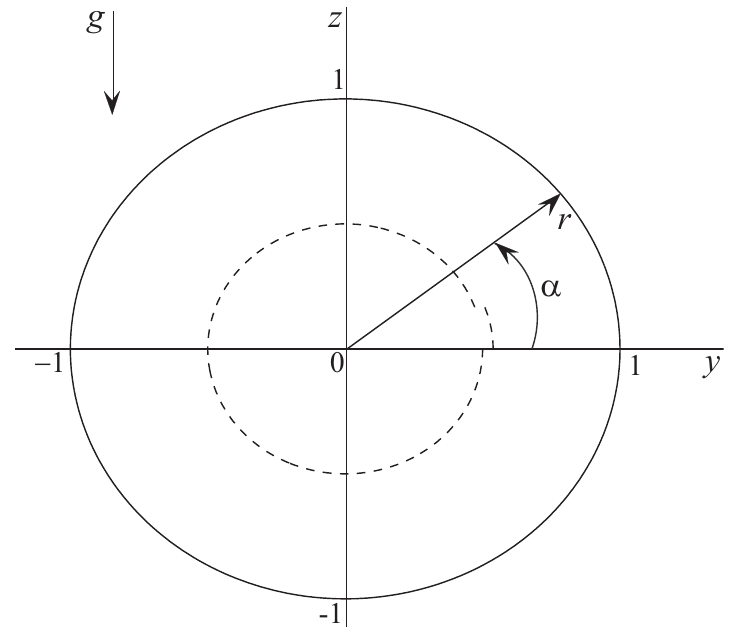
Figure 4. Frame of